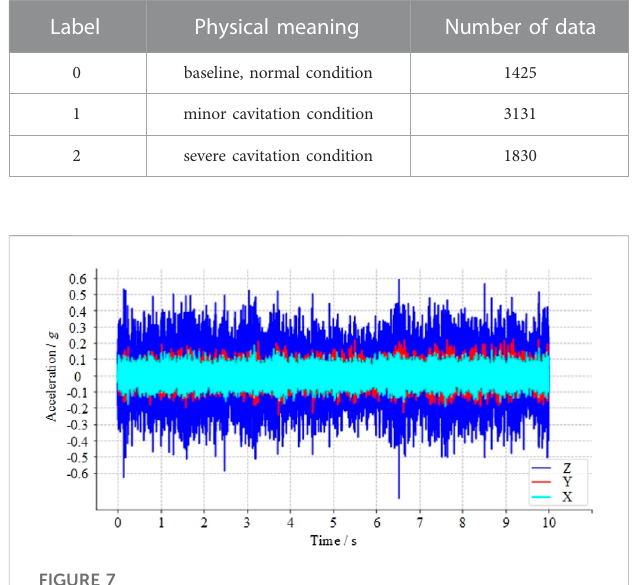
FIGURE 7 Vibration signals s under normal condition.